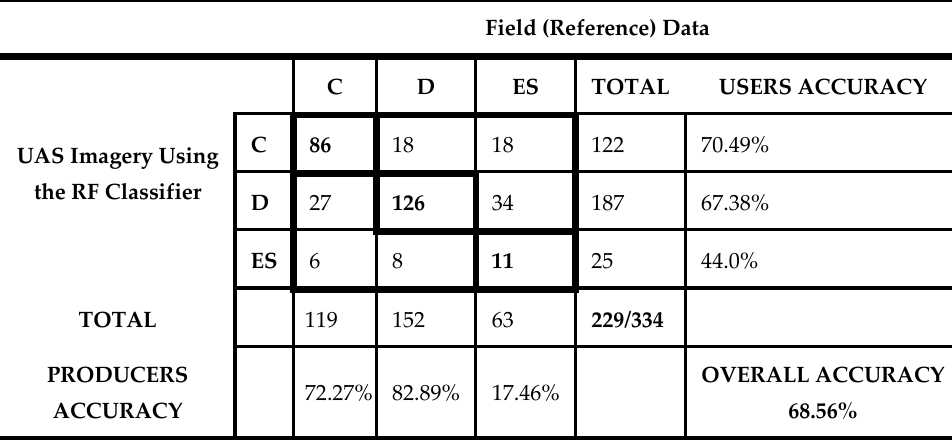
Table 9. Thematic map accuracy assessment error matrix for individual trees using the UAS imagery and the RF algorithm for three classes.